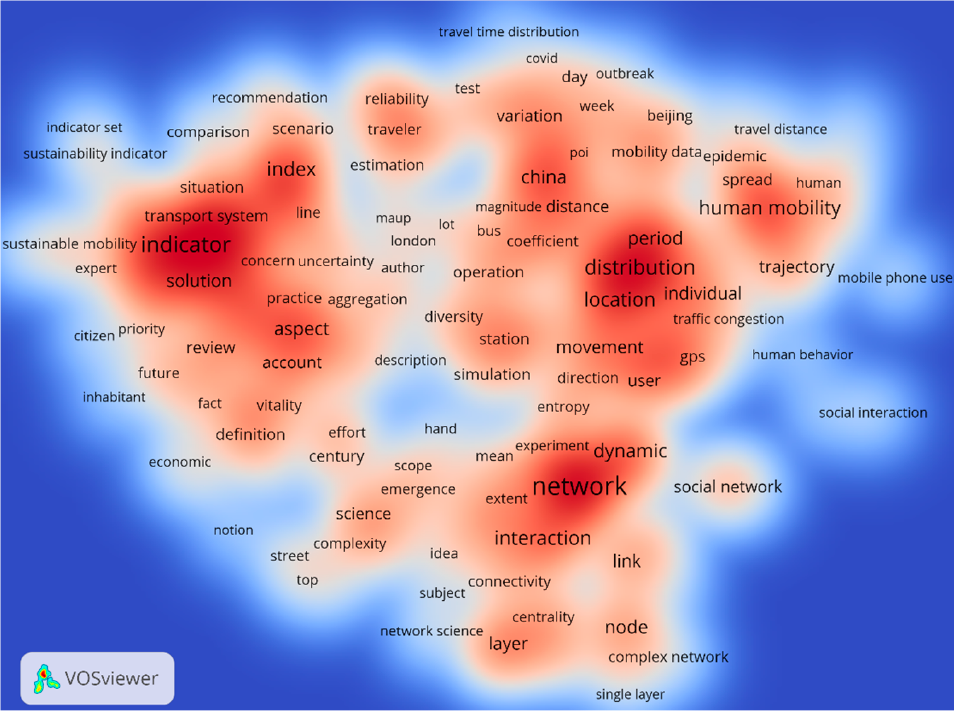
Figure 2. Density map of co-occurrence network of keywords.